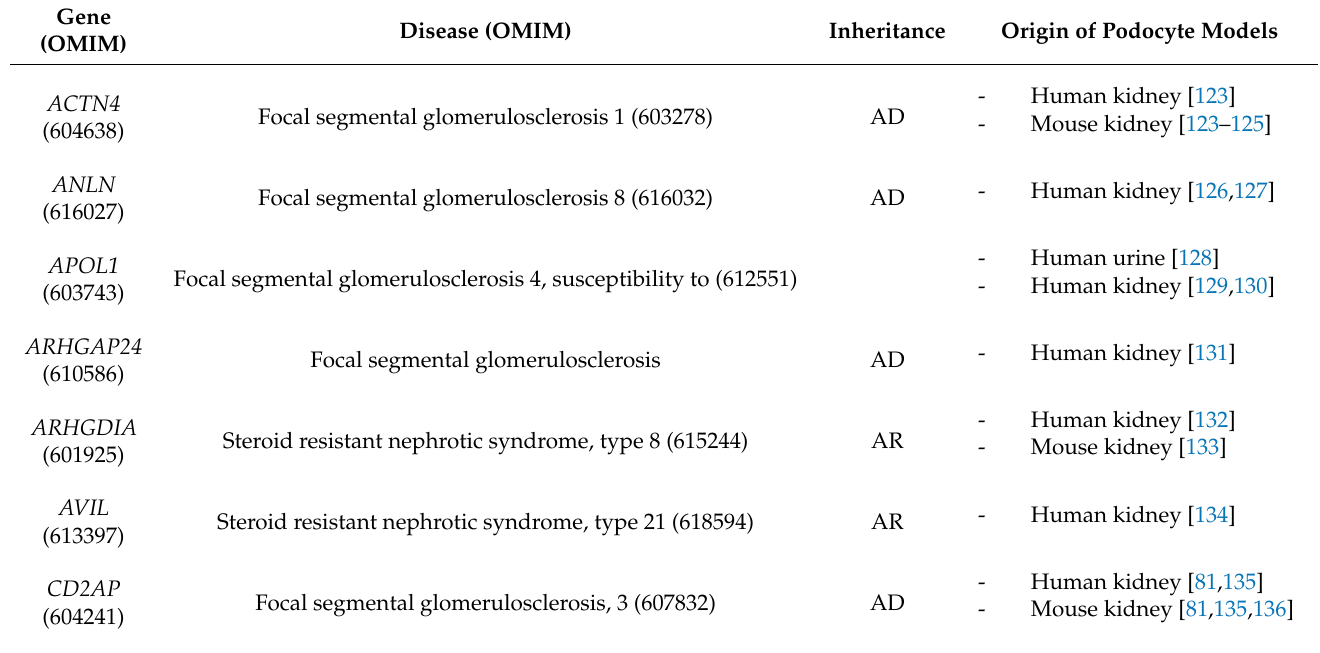
Table 1. Cell models of genetic